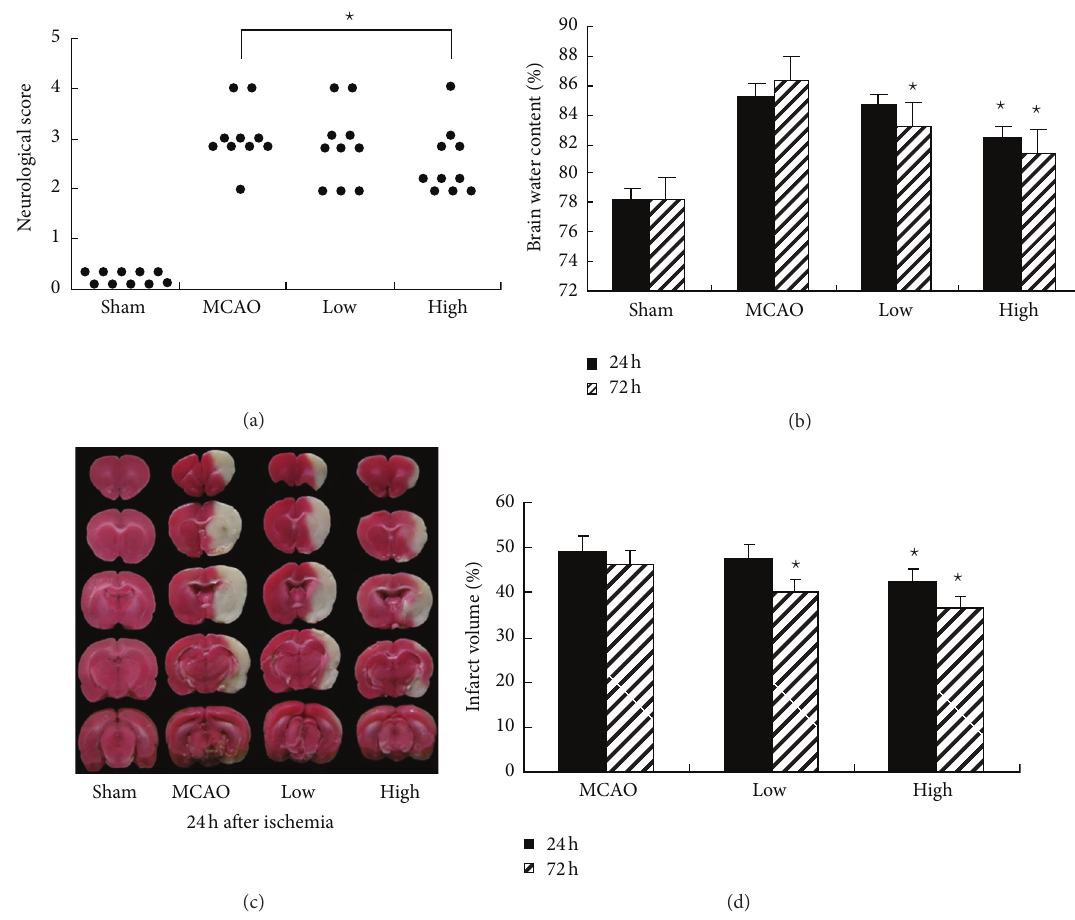
Figure 2: PN improved neurological outcome after MCAO. (a) shows the neurological deficit scores at 24h. Each circle represented the score for a single rat. Compared with MCAO group, the neurological deficit scores were significantly decreased in High group at 24 h and 72 h. ⋆ 𝑃 < 0.05 versusMCAOgroup.(b)showsthewatercontentofipsilateralhemispheres.ComparedwithMCAOgroup,thebrainwatercontent of ipsilateral hemispheres significantly was reduced in High group at 24 h and 72 h, but only at 72 h in Low group after MCAO ⋆ 𝑃 < 0.05 versus MCAO group. (d) shows infarct volume at 24h and 72h. Compared with MCAO group, the infarct area was significantly reduced in High group at 24 h and 72h, but only at 72h in Low group after MCAO. ⋆ 𝑃 < 0.05 versus MCAO group. Representative photographs in (c) shows brain slices stained with